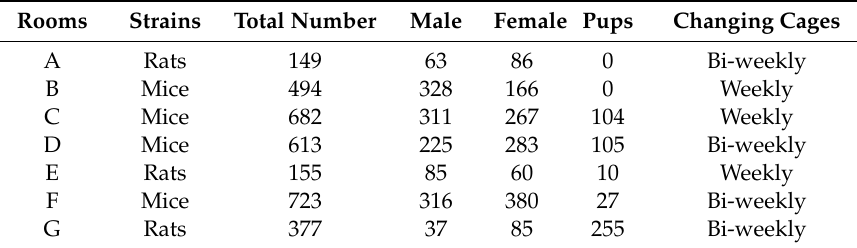
Table 1. Animals housed in each investigated room during the study and frequency of changing